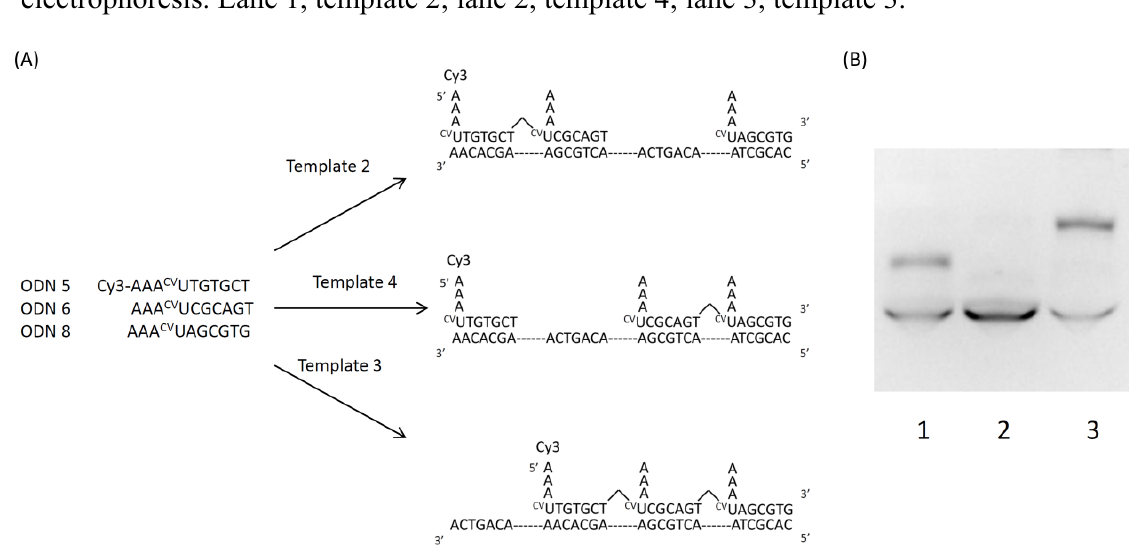
Figure 6. Scheme and denaturing PAGE analysis of a template directed DNA photoligation. ( A ) ODN-5 (10 μ M), ODN-6 (10 μ M ), ODN-8 (10 μ M) and template 2, 4 or 3 (10 μ M) irradiation at 366 nm for 1,800 s; ( B ) Cy3 fluorescent of denaturing polyacrylamide gel electrophoresis. Lane 1, template 2; lane 2, template 4; lane 3, template 3.